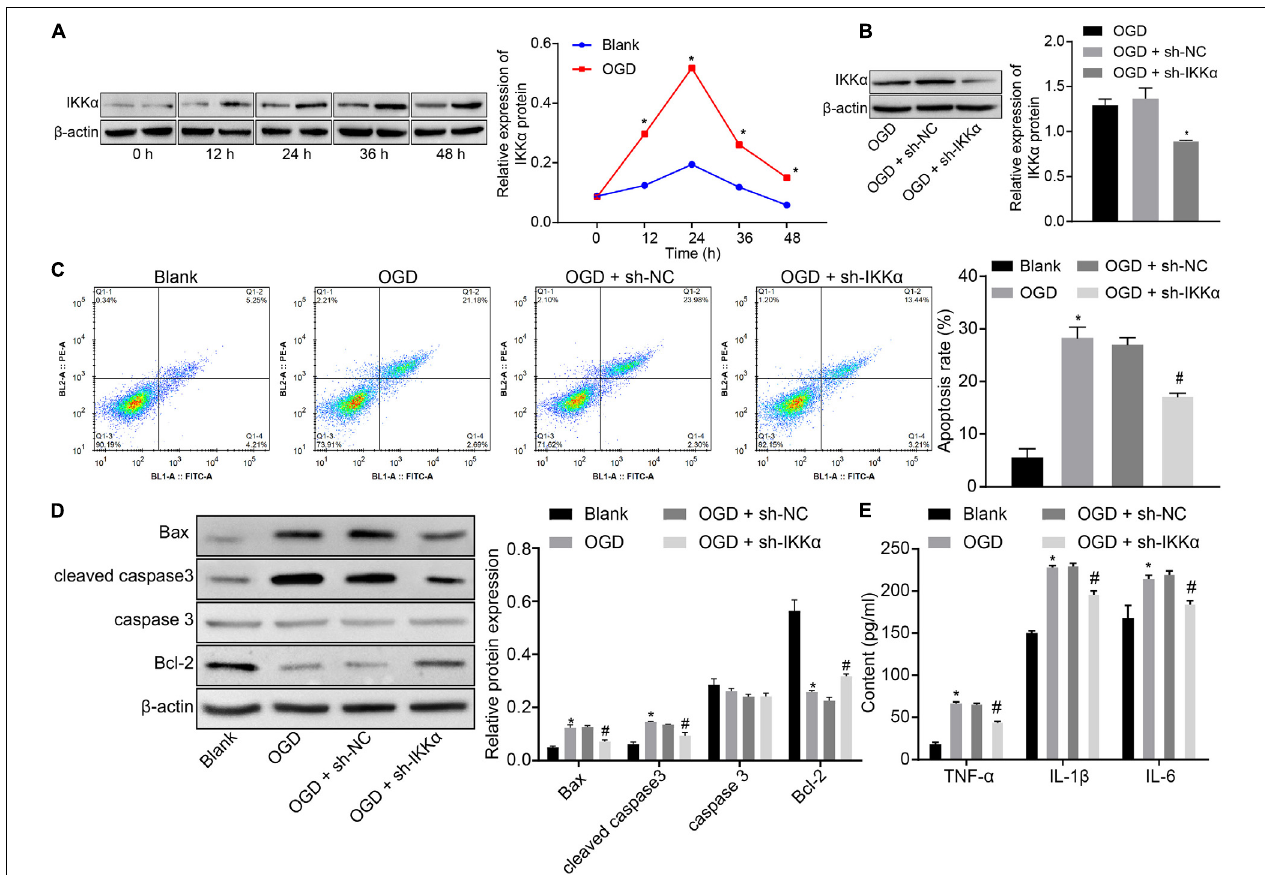
FIGURE 2 | Inhibition of IKK α suppresses OGD-induced neuronal cell apoptosis. (A) The protein expression of IKK α normalized to β -actin at different time points after OGD treatment determined by western blot analysis. (B) The protein expression of IKK α normalized to β -actin at different time points after knockdown of IKK α measured by western blot analysis. (C) The apoptosis of neuronal cells examined by flow cytometry. (D) Western blot analysis for the determination of the expression of apoptosis-related proteins (cleaved caspase 3, Bax, Bcl-2, and caspase 3 expression) normalized to β -actin in neuronal cells. (E) Expression of inflammatory cytokine (TNF- α , IL-1 β , and IL-6) in the cell supernatant determined by ELISA. * p < 0.05 vs. the blank group (neuronal cells without OGD treatment); # p < 0.05 vs. OGD-exposed neuronal cells treated with sh-NC. Measurement data were expressed as mean ± standard deviation. Unpaired data in compliance with normal distribution and homogeneity between two groups were compared using an unpaired t -test. Comparisons among multiple groups were conducted by one-way ANOVA with Tukey’s post hoc test. Data at different time points were compared by repeated-measures ANOVA, followed by Bonferroni’s post hoc test. The experiment was repeated three times